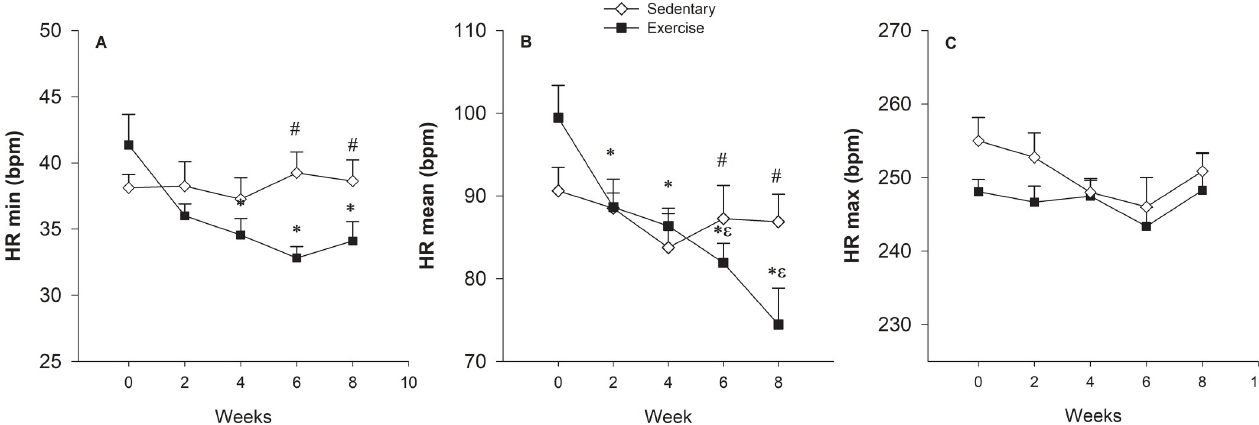
Fig 4. Changes in minimum heart rate (HR min ) (A), mean heart rate (HR mean ) (B), and maximum heart rate (HR max ) (C). Bars are standard errors. # Indicates difference between groups; � Indicates difference in relation to week 0; ε difference in relation to week 2 and 4. (p < 0.05).